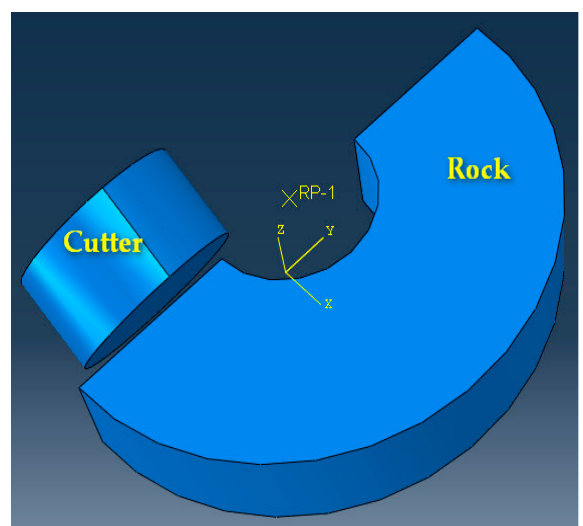
Figure 4. Numerical simulation model of a cutter breaking